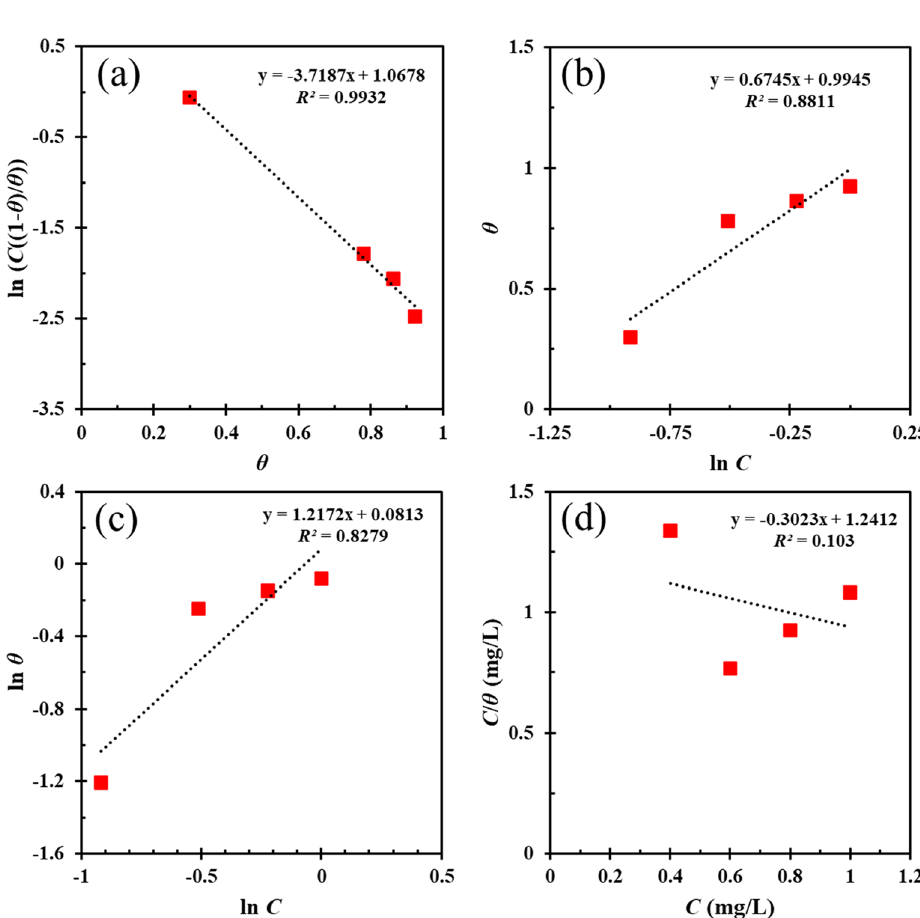
Figure 6. Frumkin ( a ), Temkin ( b ), Freundlich ( c ), and Langmuir ( d ) adsorption isotherms